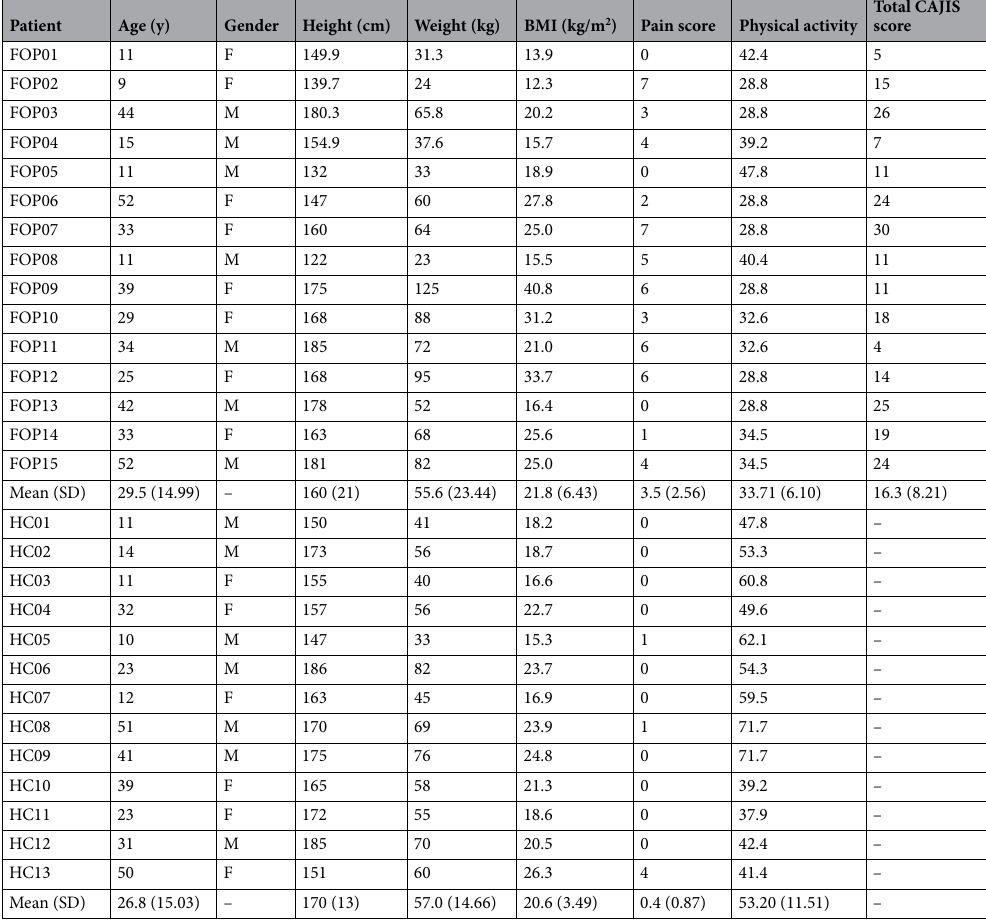
Table 1. Demographics and baseline characteristics. BMI body mass index, SD standard deviation. Pain score—0–10 scale; Average Pain Intensity over prior 7 days. PROMIS Physical Activity Scale (Short Form)— Raw scores converted to T-score for each patient; Higher scores correspond to more physical activity. Cumulative Analogue Joint Involvement Scale: CAJIS—total score ranging from 0 to